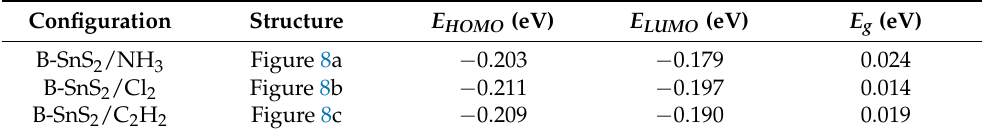
Figure 8. HOMO and LUMO of gas-adsorbed B-SnS 2 systems: ( a ) B-SnS 2 /NH 3 , ( b ) B-SnS 2 /Cl 2 , ( c ) B- SnS 2 /C 2 H 2 . Table 4. Energy of HOMO, LUMO, and energy gap of B-SnS 2 and adsorption systems.